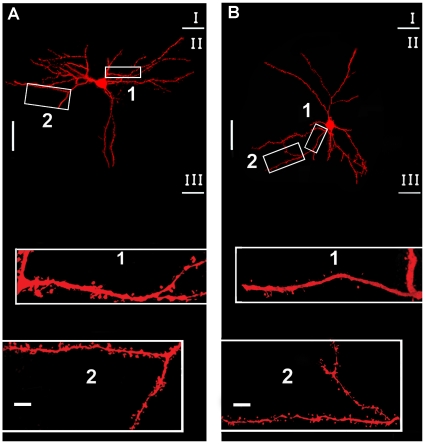
Differences in dendrite spines between F-ERF and S-ERF pyramidal neurons identified with streptavidin-Texas Red.(A) Image of an F-ERF neuron in layer II/III (SI = 0.25, cell No. 5 in Table 1). (B) Image of an S-ERF neuron in layer II/III (SI = −0.57, No. 25 in Table 1). The magnified images in squares 1 and 2 illustrate the differences in spine morphology between the F-ERF (A) and the S-ERF neurons (B). Scale bar in A and B:100 µm, and in insets: 5 µm.